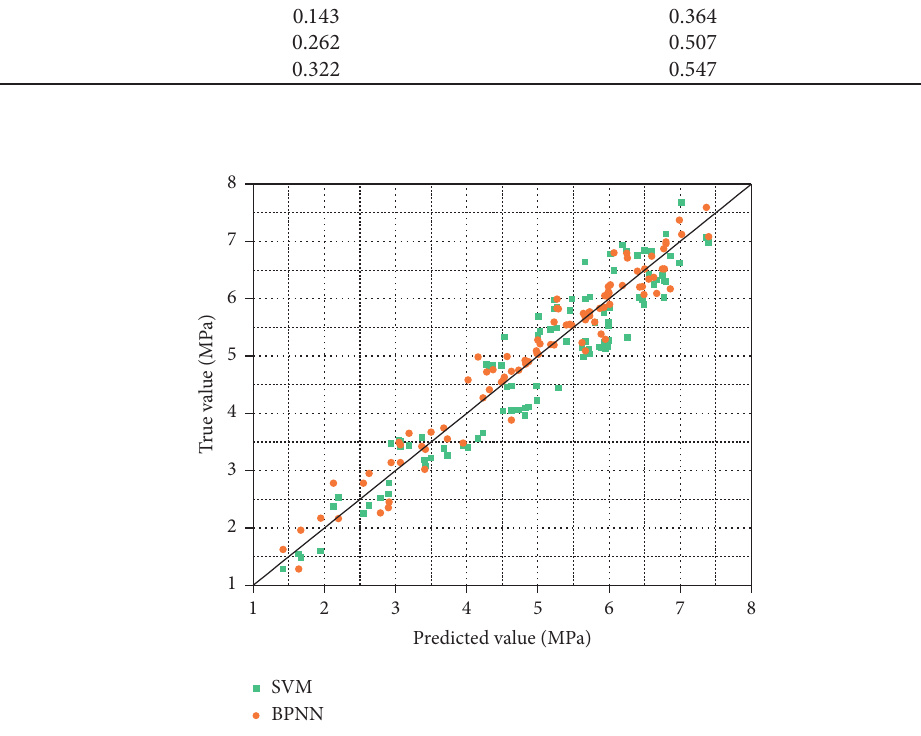
Figure 14: The correlation between actual and predicted output using the machine learning methods. Table 7: Number of samples and corresponding percentage in the error range from machine learning predictions. Error